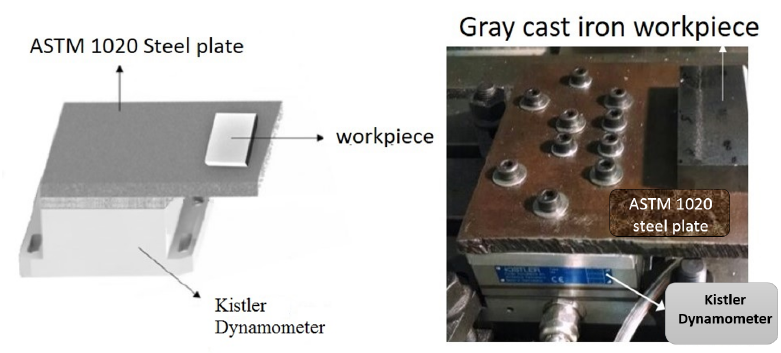
Fig. 3. Built device for